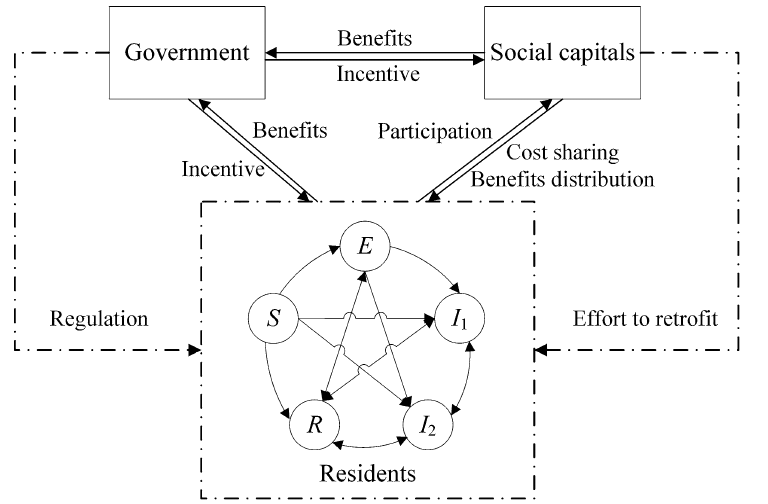
Figure 1. Analytic